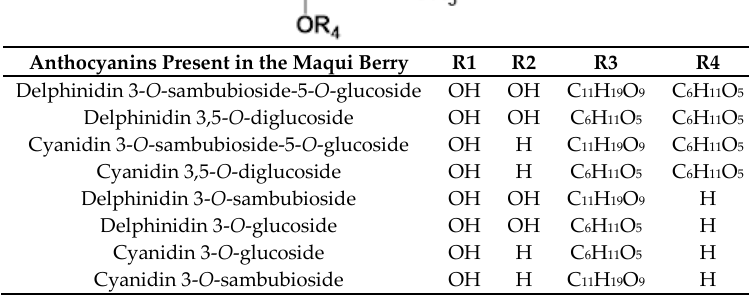
Figure 1. Radicals of the different anthocyanins present in the maqui berry.